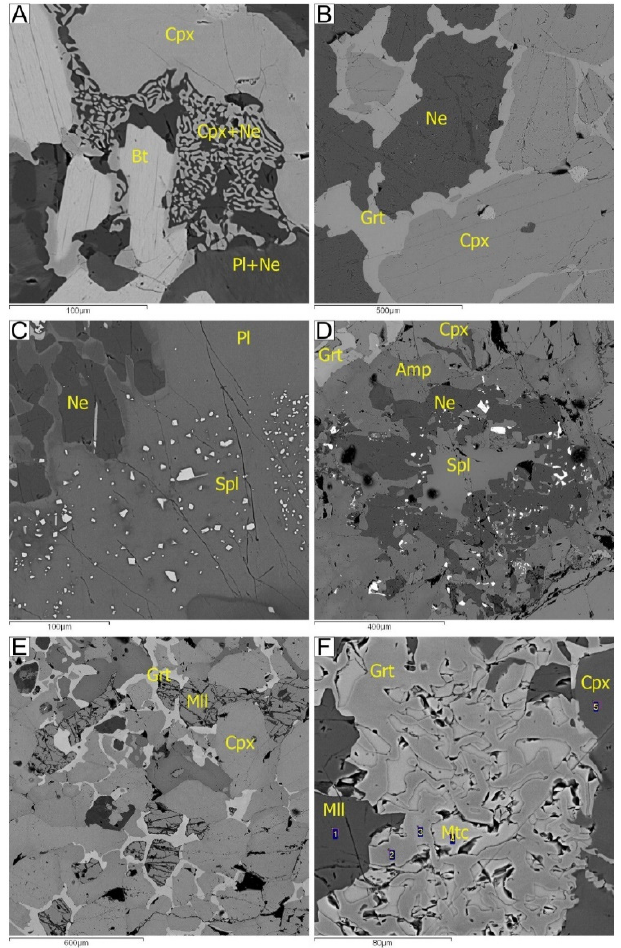
Figure 12. BSE images of dolerite and skarned pyroxenite. ( A ) nepheline-pyroxene symplectites be- tween grains of pyroxene, biotite, and nephelinized plagioclase in dolerite; ( B ) interstitial garnet between fassaite and nepheline grains; ( C ) small crystals of spinel in plagioclase from dolerite; ( D ) resorbed spinel in a nepheline coat; ( E ) interstitial garnet between fassaite and melilite grains; ( F ) garnet-monticellite symplectites between melilite and fassaite grains.